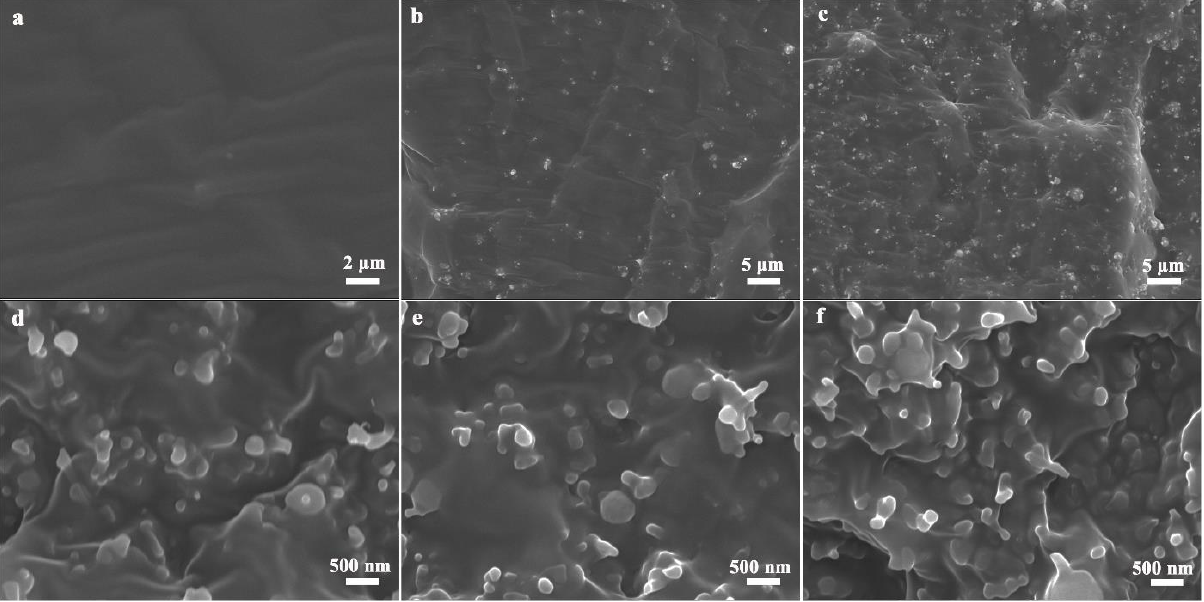
Figure 2. SEM images of fracture surface of ( a ) neat SR and B-Al 2 O 3 /SR composites with different filler content of ( b ) 10 wt%, ( c ) 30 wt%, ( d ) 50 wt%, ( e ) 60 wt% and ( f ) 70 wt%.